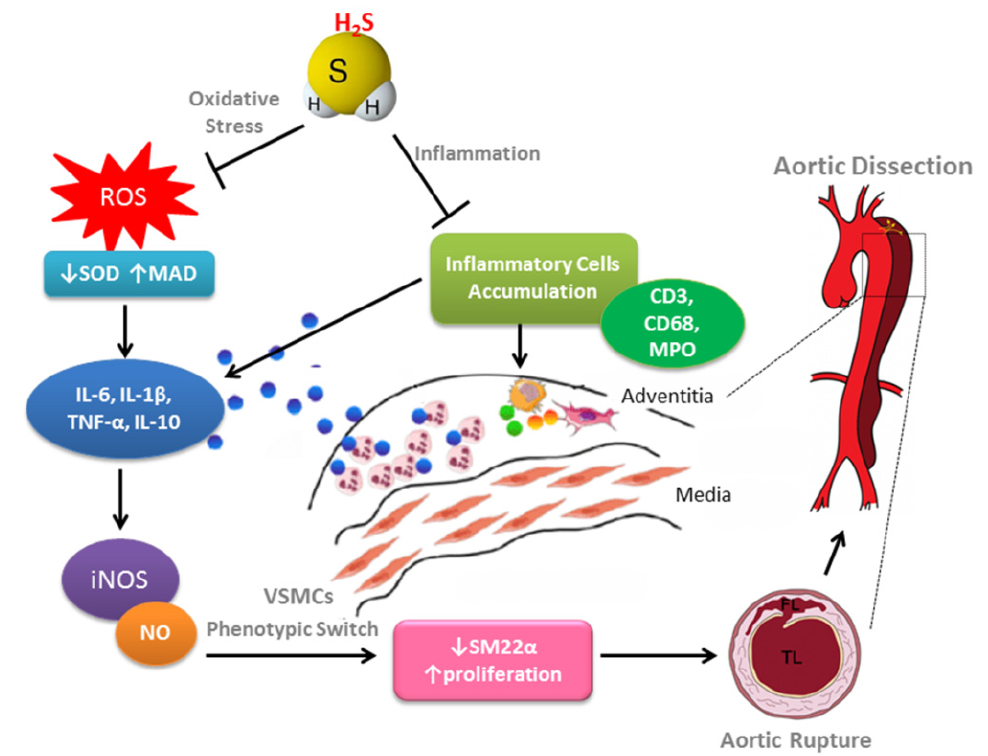
Figure 7. The proposed mechanism of H 2 S protects against AD formation. Exogenous H 2 S plays a protective role in vascular remodeling that involves the regulation of oxidative stress, inflammation, NO bioavailability, and cell death. Additionally, the phenotypic switch of VSMCs is a critical characteristic for AD progression and development. H 2 S inhibits IL-6-induced phenotypic switch of VSMCs through the ROS-NO-iNOS pathway.